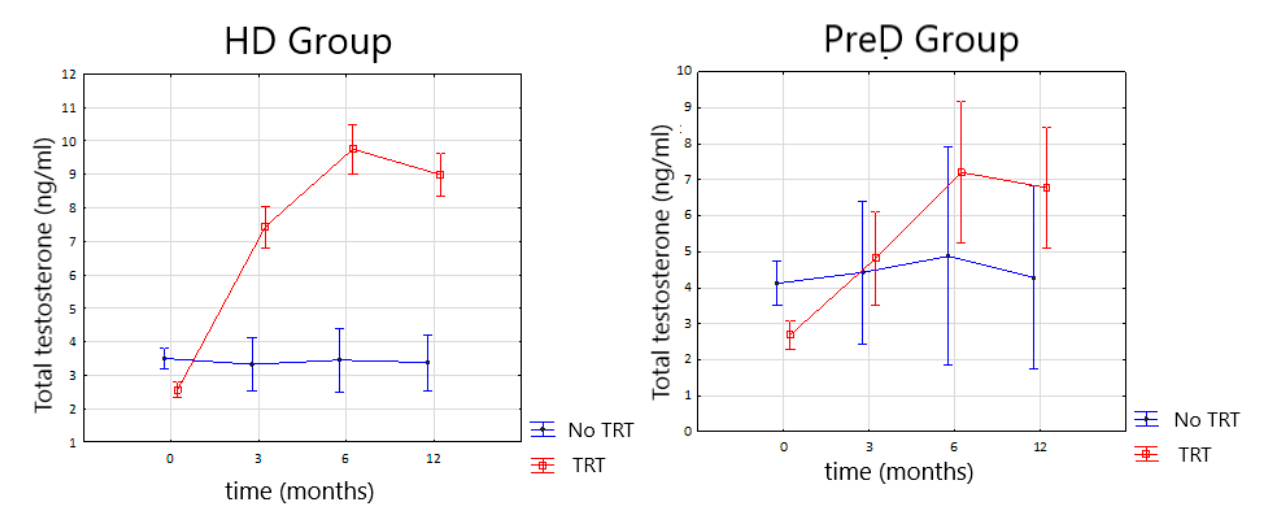
Figure 1. Changes in the total testosterone serum concentration during TRT (testosterone replacement therapy) in the HD (hemodialysis) and PreD (predialysis) groups.